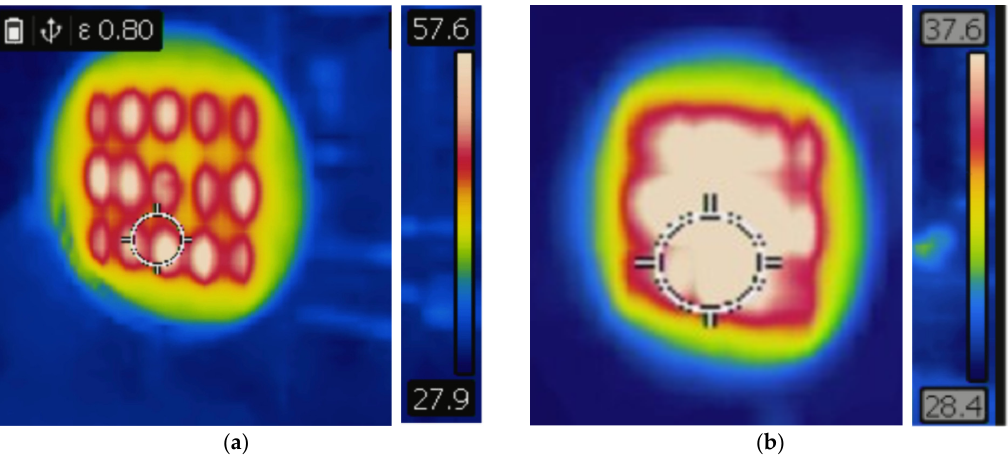
Figure 5. Thermal image of dipole array through Pulse Wave: ( a ) with cooling; ( b ) no cooling.